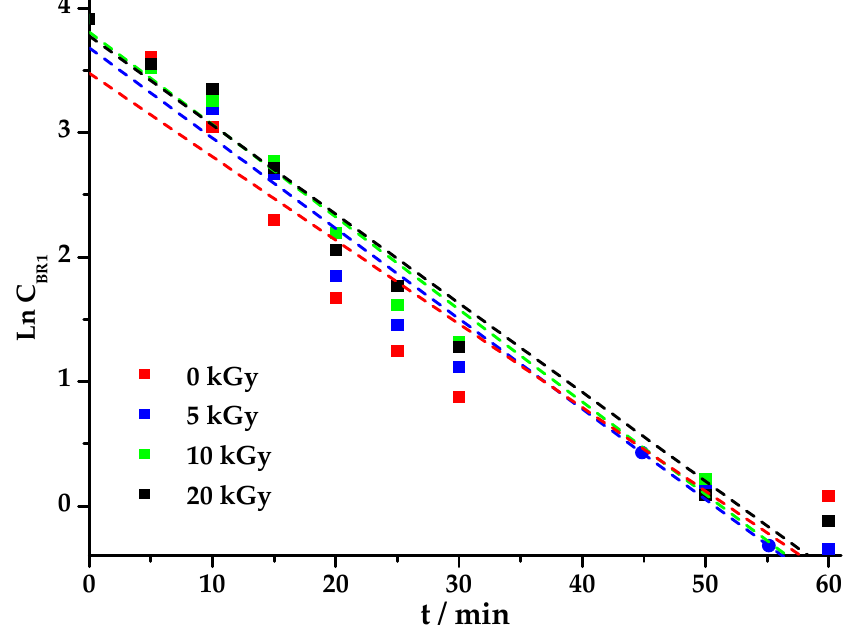
Figure 8. DB1 linear adjustment according to pseudo first order kinetics, data from Figure 7. Table 2. Rate constants for pseudo first order reaction at different irradiation doses.